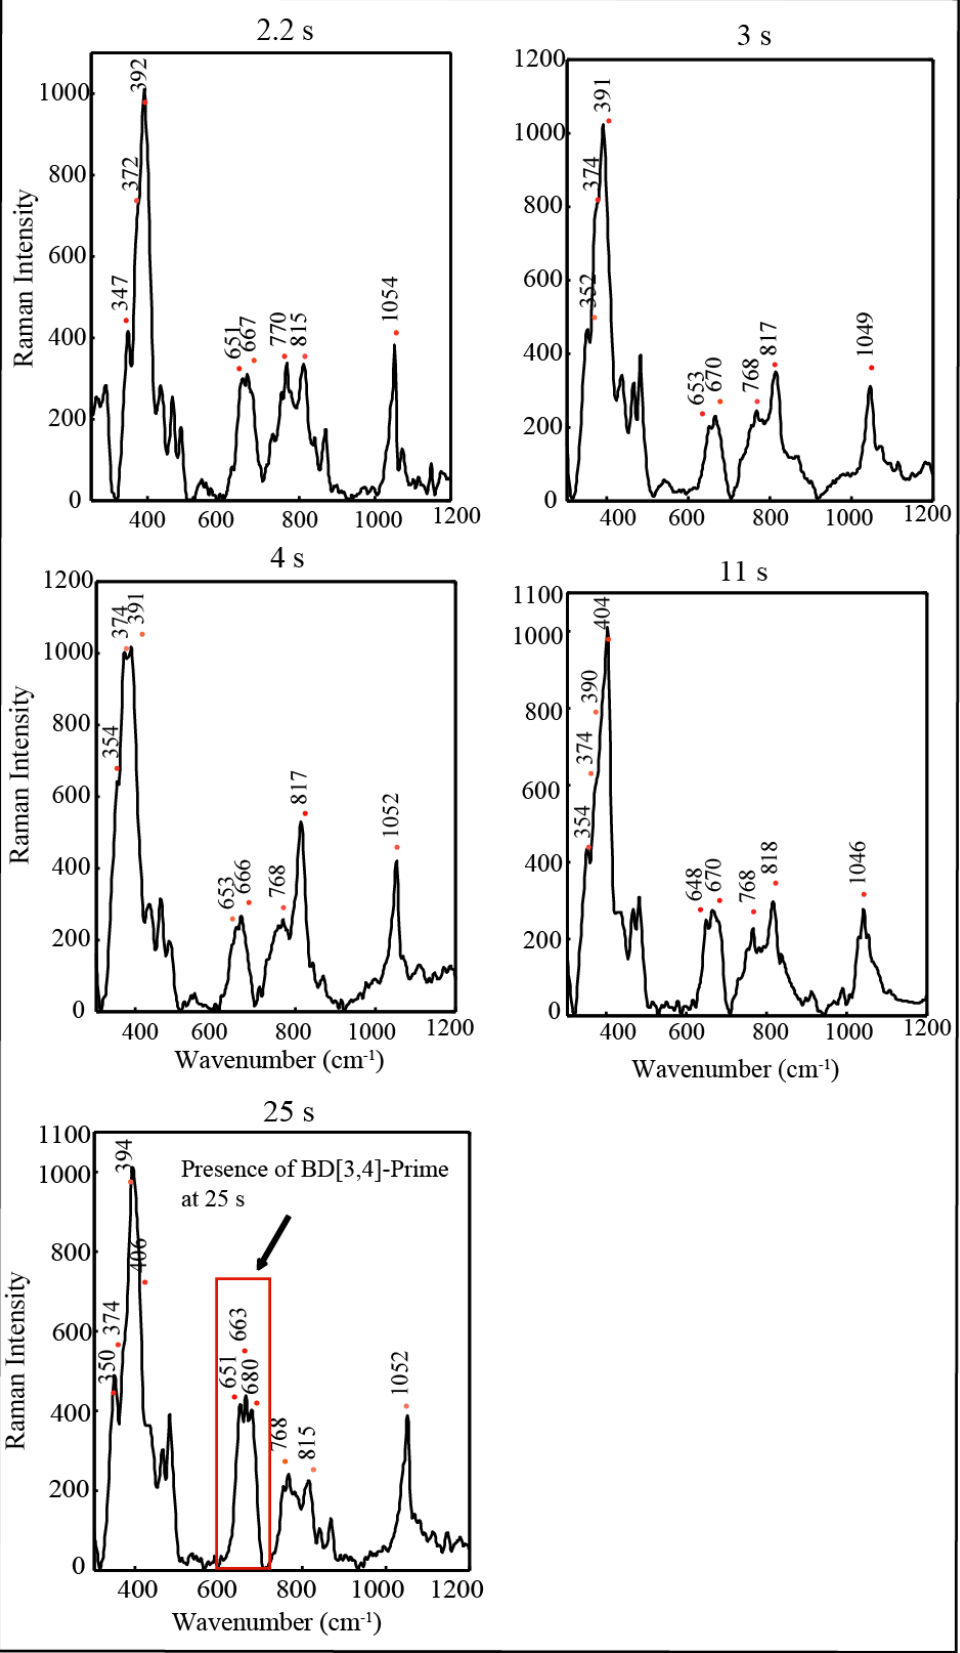
Figure 7. Resonance Raman measurements of 0.25 mM BD[3,4] with 20 equiv Ce(IV) in DNO , pH = 1 freeze quenched at time intervals shown in Figure 3